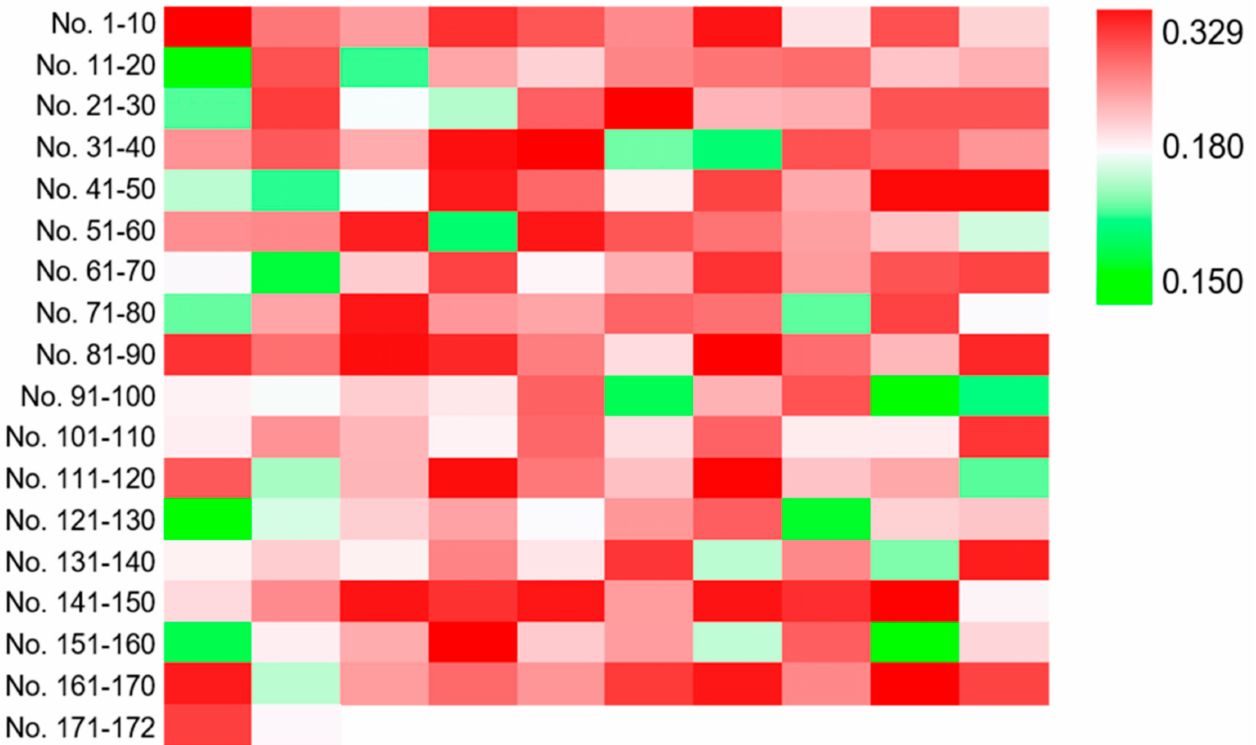
Figure 2. Heatmap for the NADH/NAD + ratios of the mutants selected from the DNP plate. The NADH/NAD + ratio of YJ-002 was 0.180. The strains with an increased NADH level are marked in red, and those with a decreased value are marked in